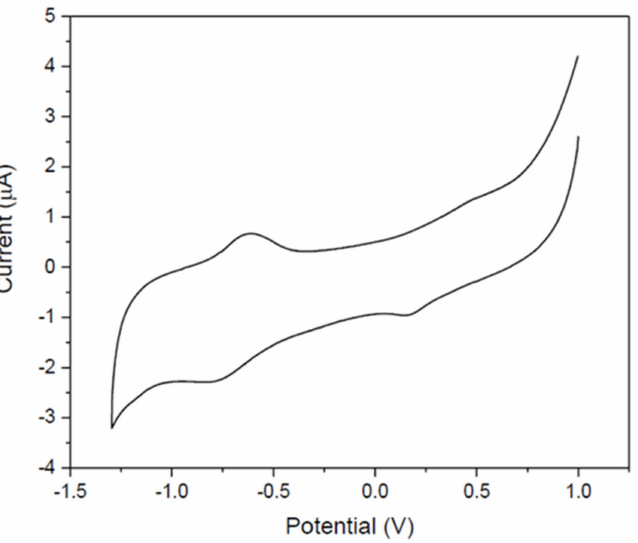
Figure 6. Cyclic voltammogram of polymer 1 in 0.1 M NaClO 4 /DMSO supporting electrolyte at scan rate 100 mV s − 1